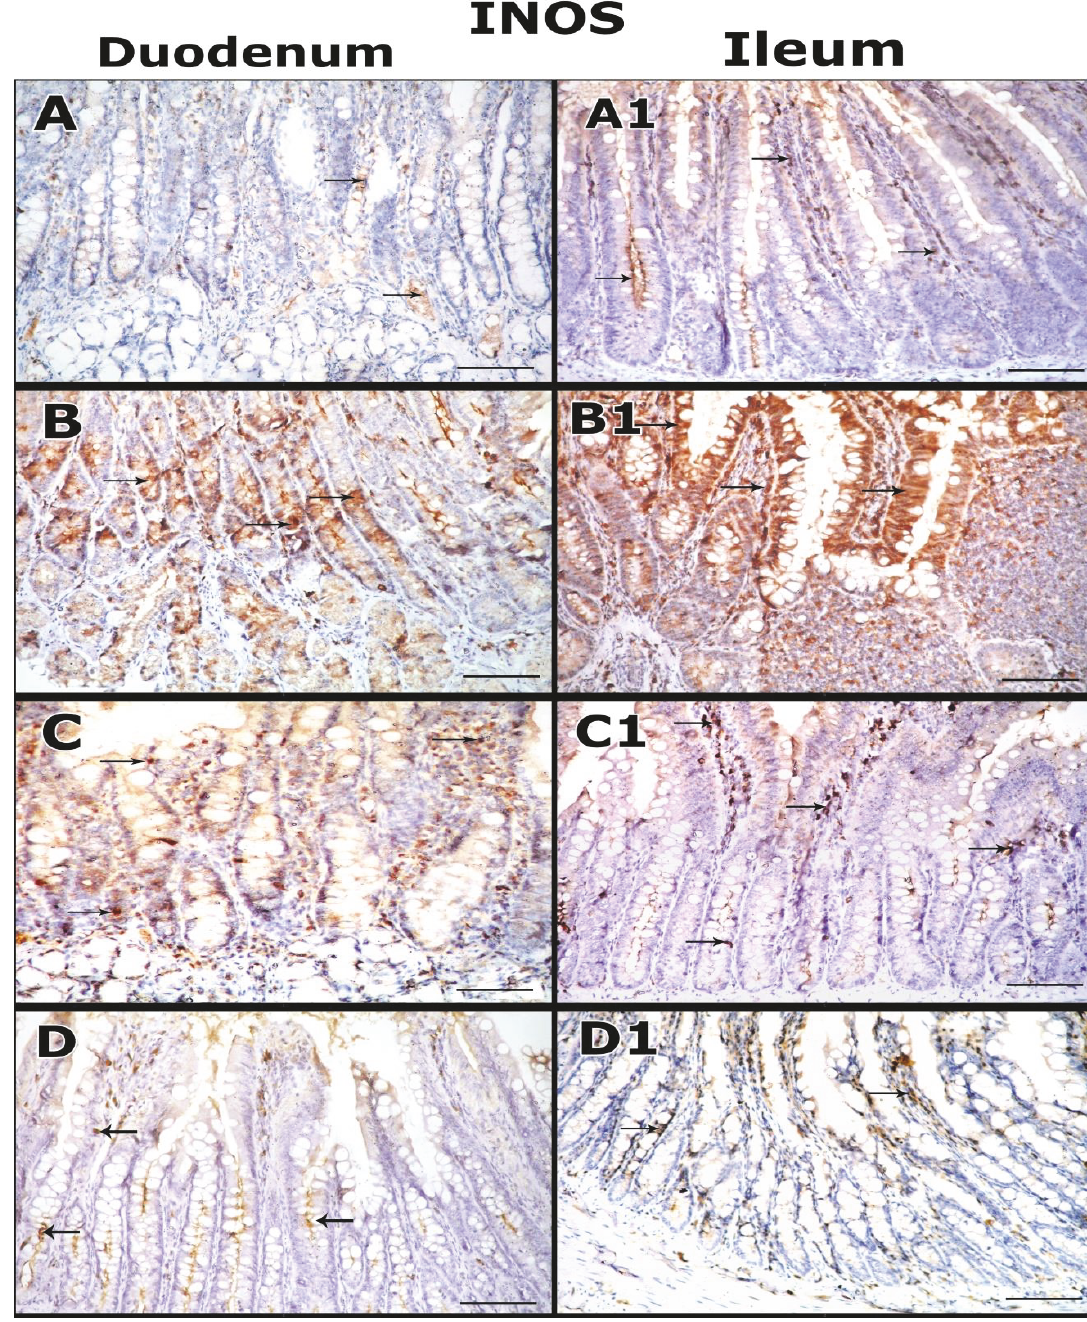
Figure 4: Immunohistochemicalstaining micrographs of intestinal tissues (duodenum and ileum) of the studied groups for iNOS expressing cells ( arrow ). A, A1: Control group section shows few weak iNOS-positive cells. B, B1: Iron overload group section shows numerous strongly positive cells. C, C1: Iron + DFO group section shows reduction of iNOS expressing cells. D, D1: Iron+ Quercetin group shows marked reduction of the expressing cells in most areas (immunoperoxidase, haematoxylin counter-stain,